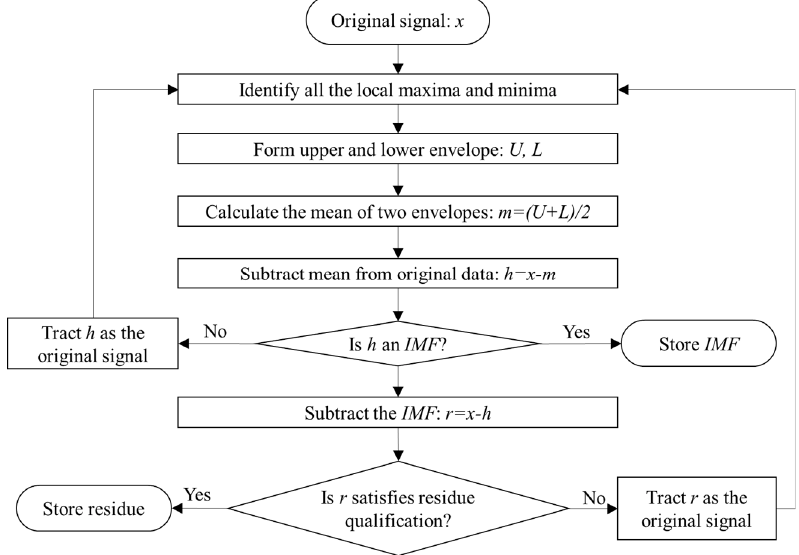
Figure 1. Flow chart of the detailed screening steps of empirical mode decomposition (EMD). Note: IMF = intrinsic mode function.